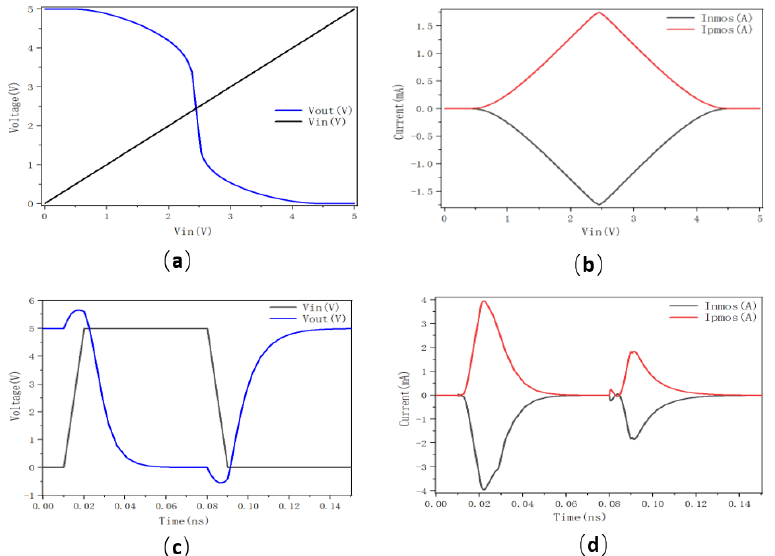
Figure 7. Transmission characteristic curve and transient characteristic curve of the CMOS inverter. ( a ) voltage transmission characteristic curve; ( b ) Current transmission characteristic curve; ( c ) voltage transient characteristic curve; ( d ) Current transient characteristic curve.